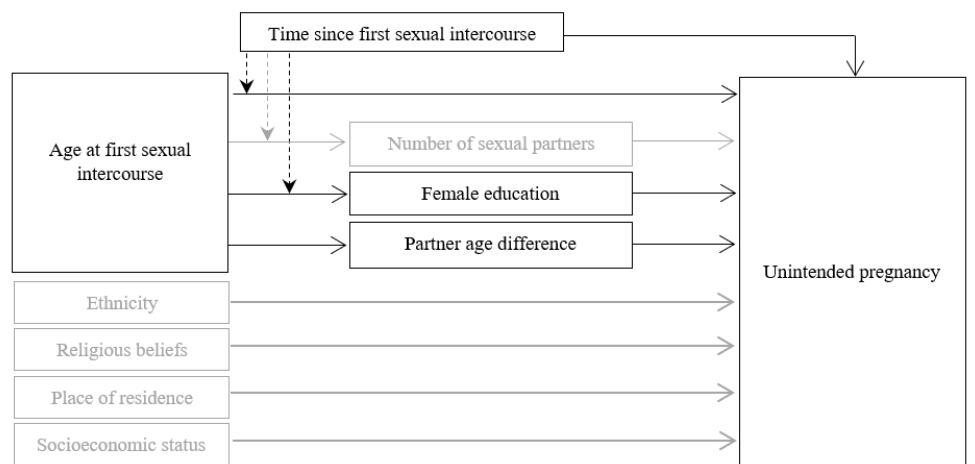
Figure 1. Conceptual model for the presumed association between age at first sexual intercourse (AFSI) and unintended pregnancy through female education and partner age difference while considering for: (1) the expected mediating role of number of sexual partners on the association between AFSI and unintended pregnancy, (2) the direct effects of ethnicity, socioeconomic status, religious beliefs, and place of residence on unintended pregnancy, and (3) the presumed moderation of the time that had passed since first sexual intercourse on the associations between AFSI and female education and between AFSI and number of sexual partners.